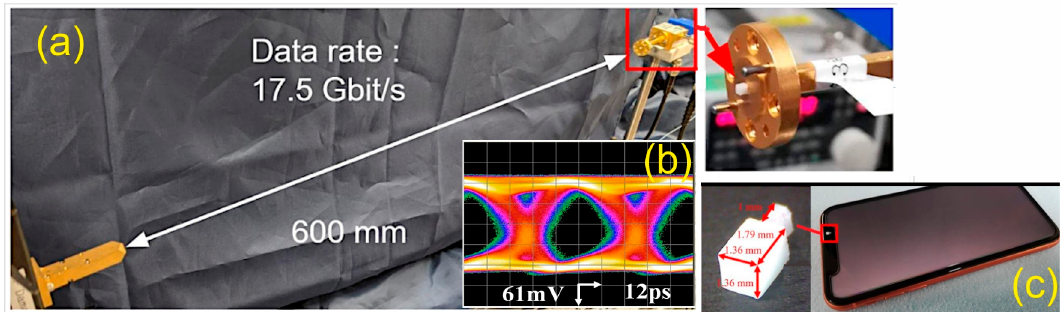
Figure 3. ( a ) Scheme of the experiment, ( b ) eye diagram: when the bit-error-rate was the smallest, ( c ) concept of antenna integrated into a mobile phone. Adapted from [86–89].